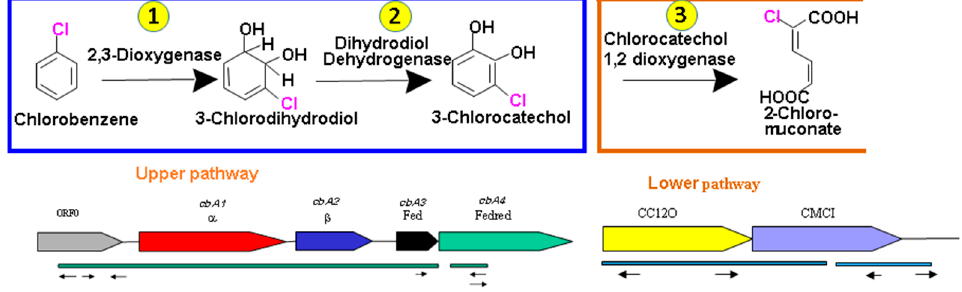
Figure 6. The catabolic pathway of chlorobenzene degradation by Alcanivorax sp. HA03. The catabolic enzyme’s (1) initial dioxygenase, (2) dihydrodiol dehydrogenase, (3) chlorocatechol 1,2 dioxygenase.